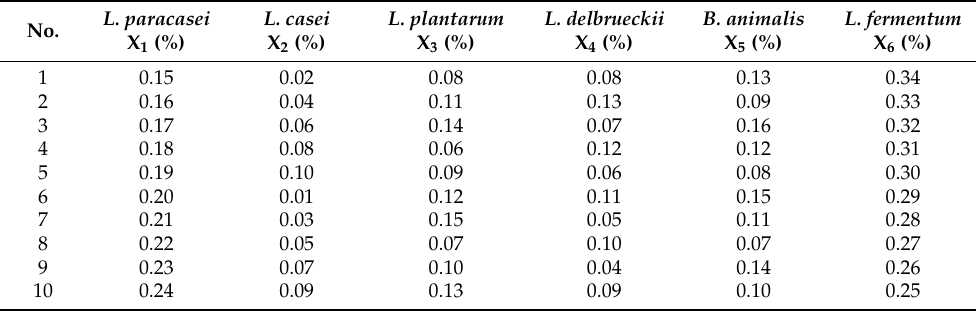
Table 1. Uniform design table for the